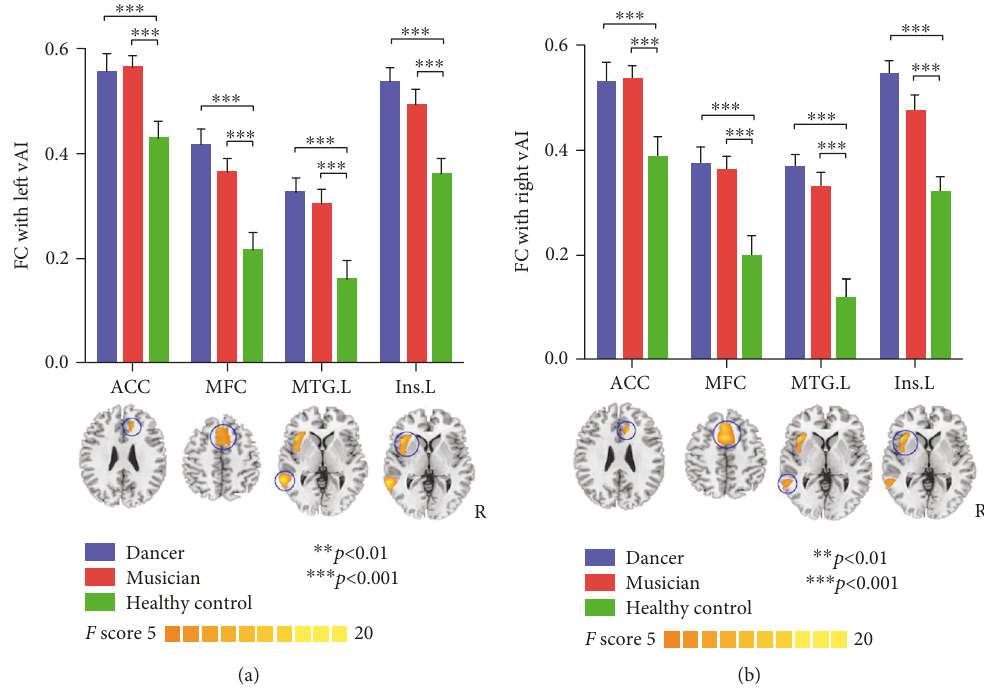
Figure 2: Functional connectivity of vAI seeds. (a) Represents the results of left vAI, and (b) represents the result of the right vAI. Increased FC is observed in ACC, MFC, left MTG, and left insula in dancers and musicians compared with controls.